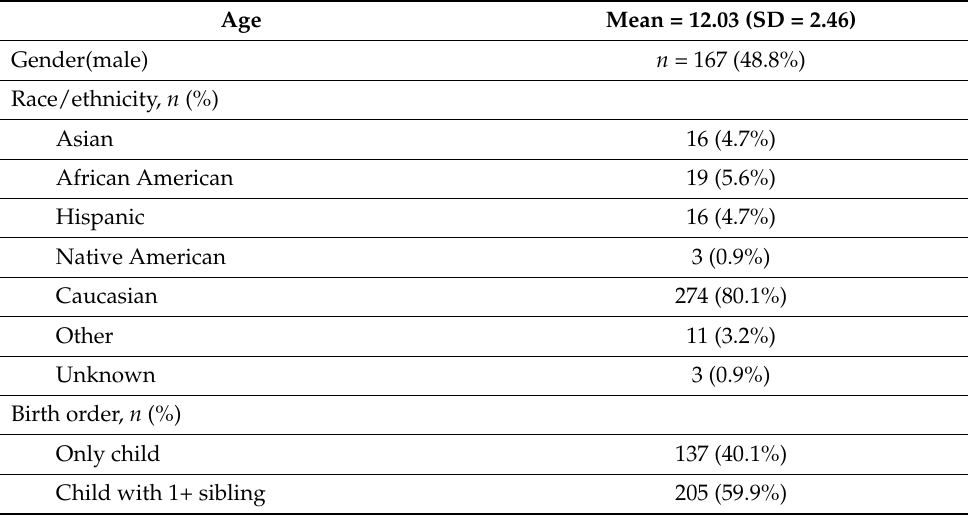
Table 1. Demographic and clinical characteristics of the children ( n = 342).